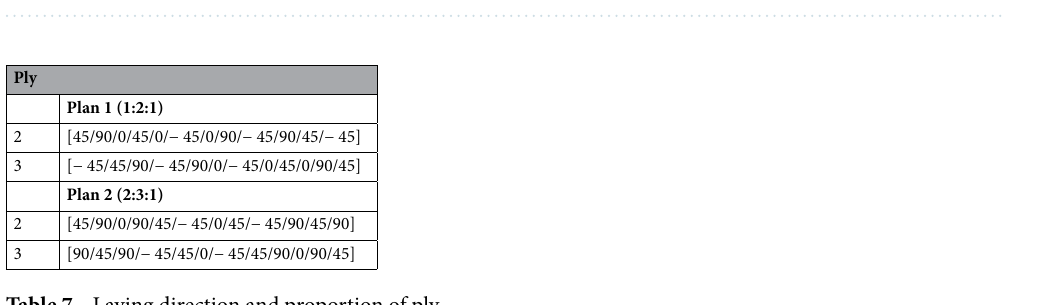
Table 7. Laying direction and proportion of